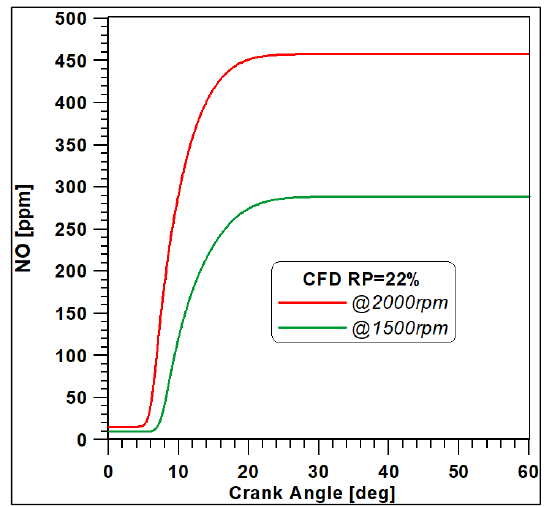
Figure 12. Numerical NO fraction for the two cases.